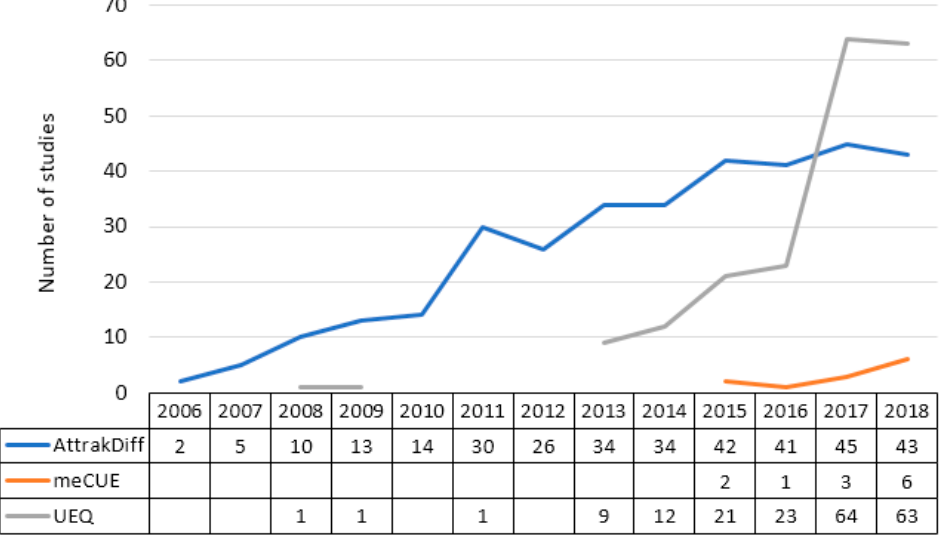
Figure 3. Total uses of standardized questionnaires by year, summarized by questionnaire.